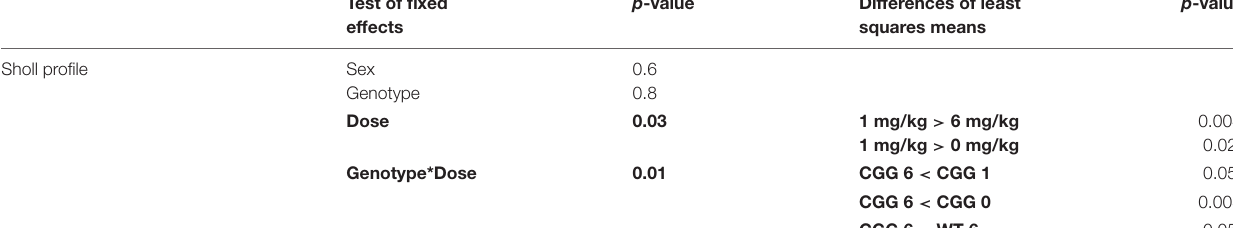
TABLE 2 | Summary of mixed model effects in pyramidal cortical